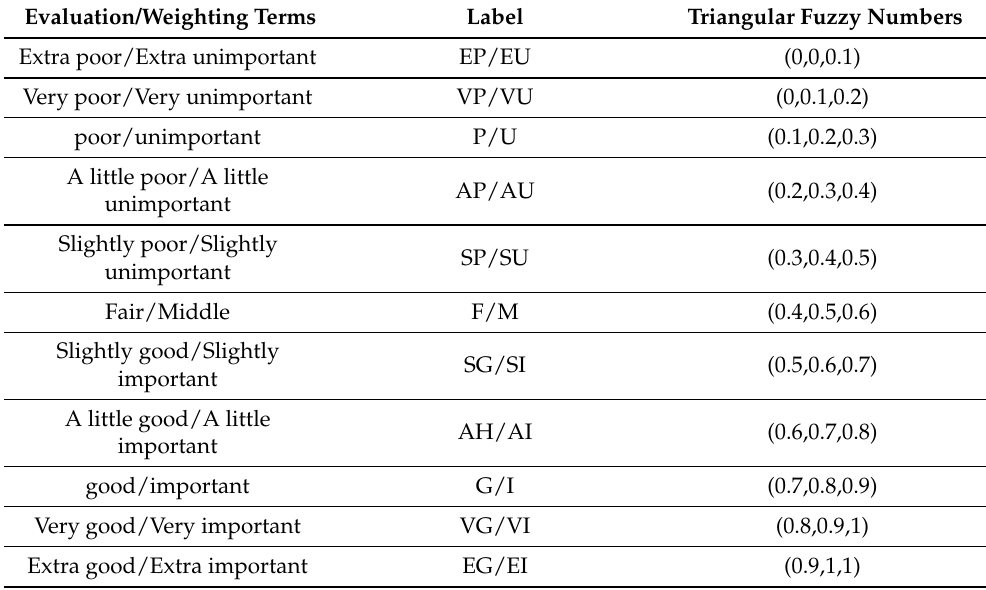
Table 1. Linguistic terms and corresponding fuzzy numbers (from [12,23]).